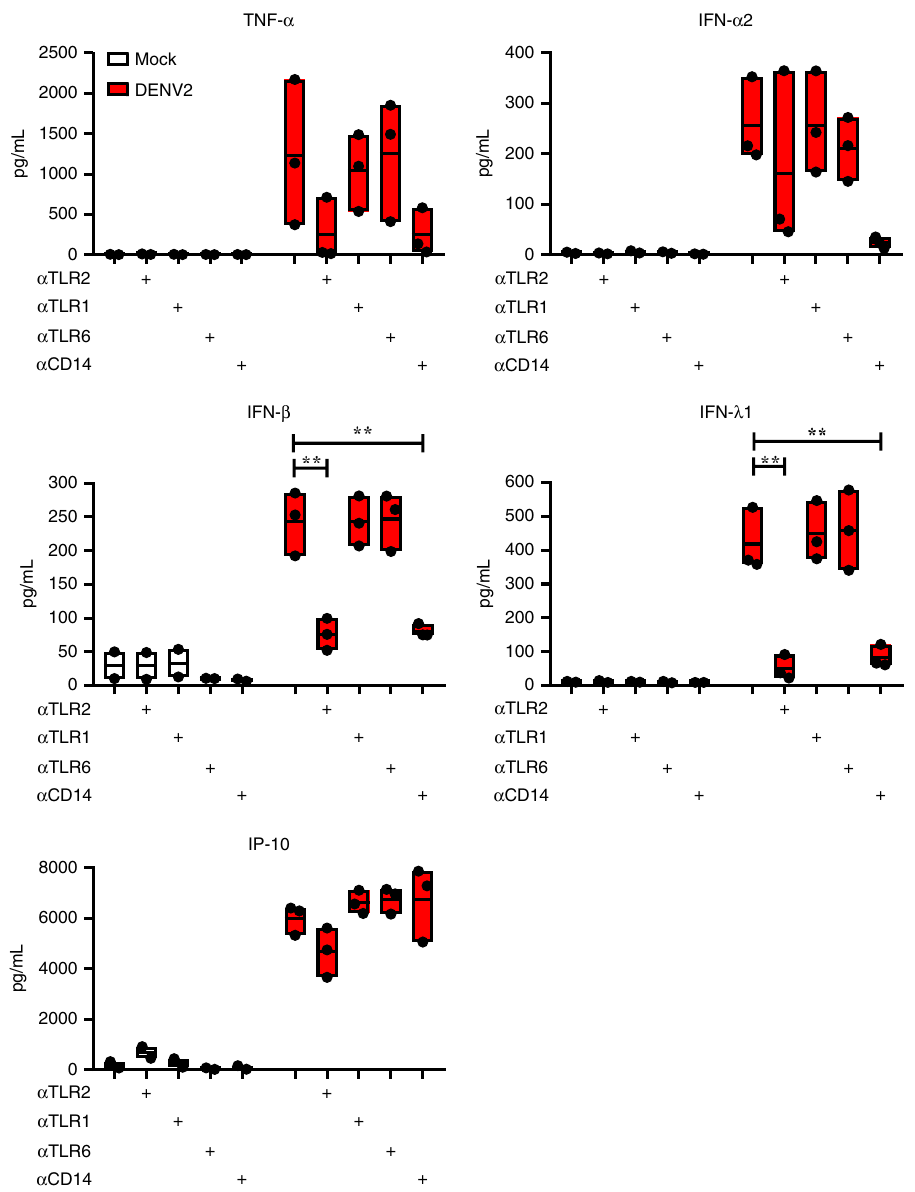
Fig. 5 TLR2/CD14-dependent cytokines induced by DENV2 infection. PBMCs from healthy donors were (mock) — treated with α TLR2, α TLR1, α TLR6 (5 µ g/mL) and α CD14 (3 µ g/mL) for 2 h prior to infection with DENV2 at MOI of 20 for 48 h ( n = 2, two different donors and 3 different DENV2 preparations, one-way ANOVA, Dunnett post hoc test, ** P < 0.01). Cytokine production was measured by fl ow cytometry using LegendPlex. Each